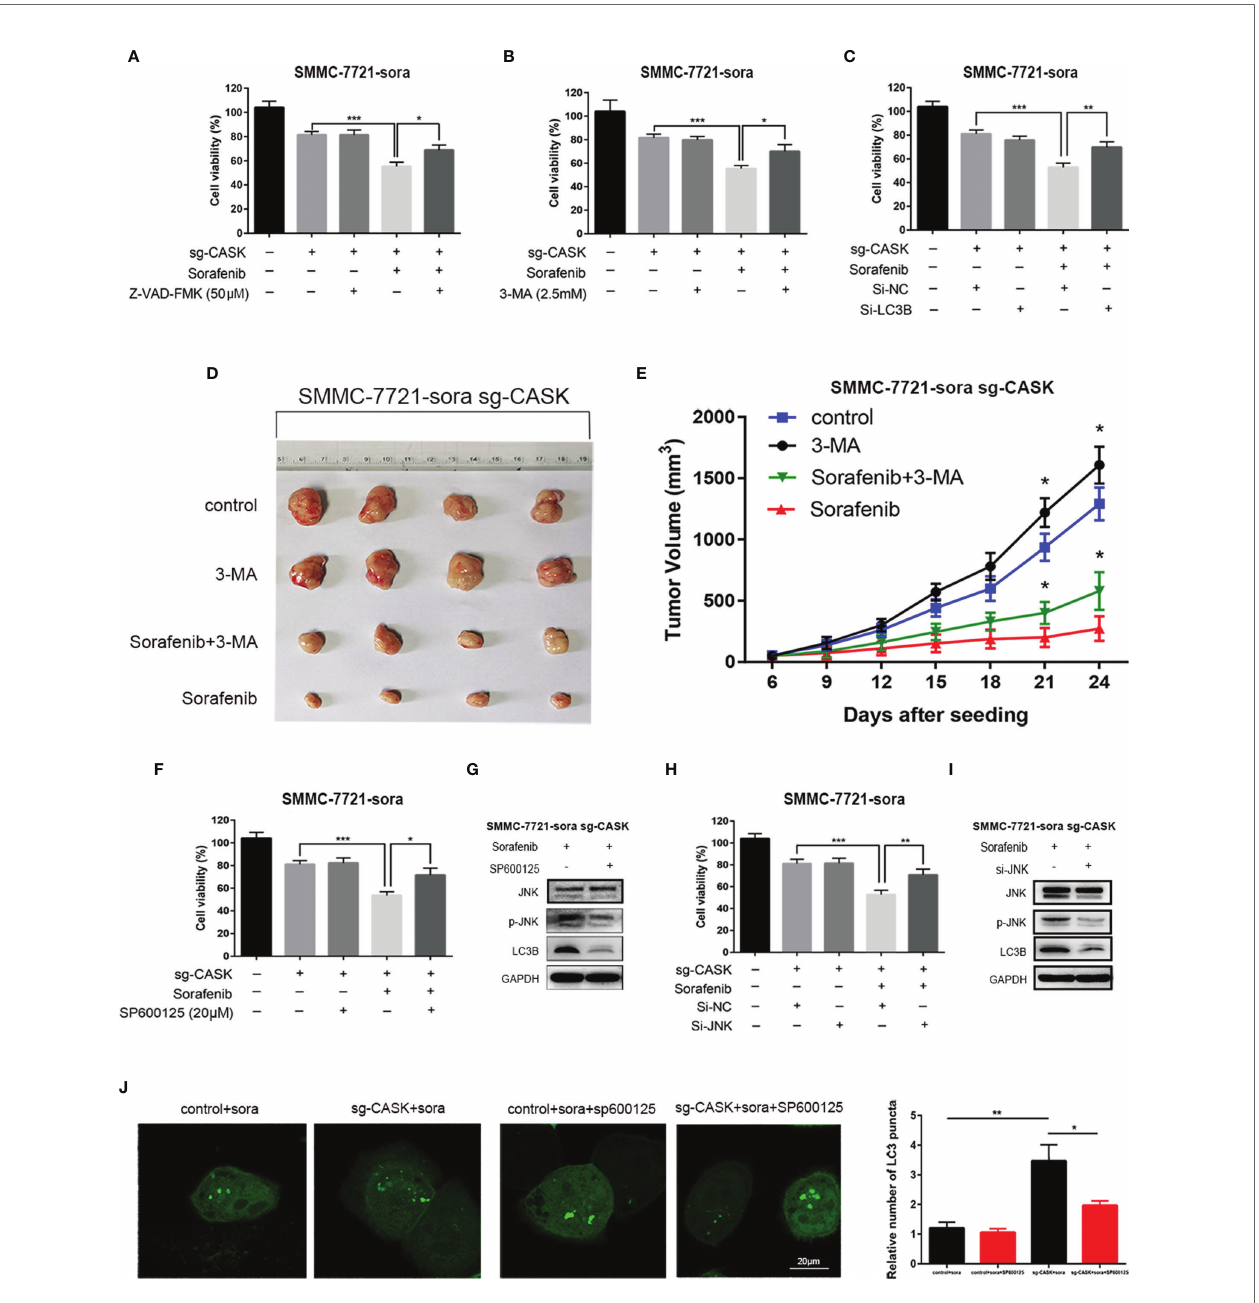
FIGURE 5 | CASK depletion increased autophagic cell death through JNK/c-Jun signaling pathway. (A) Z-VAD-FMK partly attenuates CASK knockout-mediated sorafenib-induced HCC cell death by CCK8 assay. SMMC-7721-sora cell was pretreated with or without Z-VAD-FMK (50 m M) for 2 h followed by exposure to 10 m M sorafenib for 24 h. (B) 3-MA partly attenuates CASK knockout-mediated sorafenib-induced SMMC-7721-sora cell death by CCK8 assay. Cells pretreated with or without 3-MA (2.5 mM) for 2 h, and following treated with 10 m M sorafenib for another 24 h. (C) si-LC3B partly reversed CASK knockout combine with sorafenib treatment-induced cell death by CCK8 assay. Cells pretreated with or without transiently transfected with si-LC3B for 12 h, and incubated with 10 m M sorafenib for another 72 h. (D) Representative image of CASK knockout xenograft tumors. (E) Tumor volume in each group. (F) SP600125 partly decreased CASK knockout-mediated sorafenib-induced SMMC-7721-sora cell death by CCK8 assay. Cells pretreated with or without 20 m M SP600125 for 2 h, and following treated with 10 m M sorafenib for another 24 h. (G) Western blotting were performed to detect the expression of p-JNK and LC3B following the treatment of SP600125 in SMMC-7721-sora sg-CASK cell. (H) si-JNK partly decreased CASK knockout-mediated sorafenib-induced SMMC-7721-sora cell death by CCK8 assay. Cells pretreated with or without transiently transfected with si-NC/si-JNK for 12 h and following treated with 10 m M sorafenib for another 72 h. (I) Western blotting were performed to detect the expression of p-JNK and LC3B following the treatment of si-JNK in SMMC-7721-sora sg-CASK cell. (J) CASK knockout or control cells transiently transfected with GFP-LC3 plasmid were pretreated with or without 20 m M SP600125 for 2 h. Then, cells were incubated with 12.5 m M sorafenib for 36 h. And the number of GFP-LC3 dots were visualized by confocal microscopy and quanti fi ed. *P < 0.05, **P < 0.01, ***P <